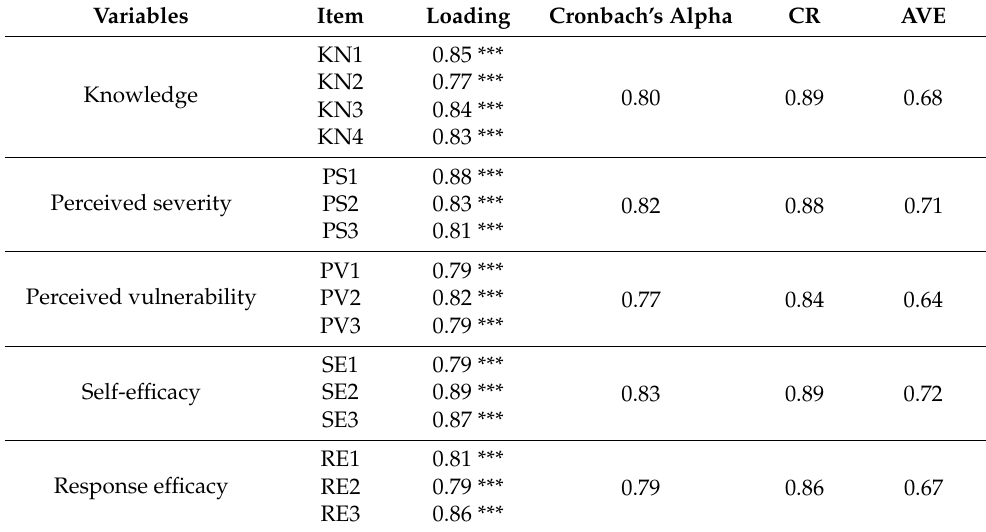
Table 1. Reliability and validity analysis. Variables